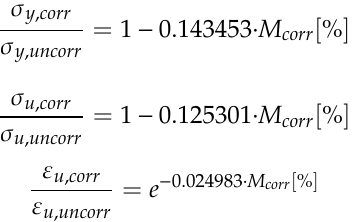
Figure 3. Mesh size and finite element model of one half of the beam.